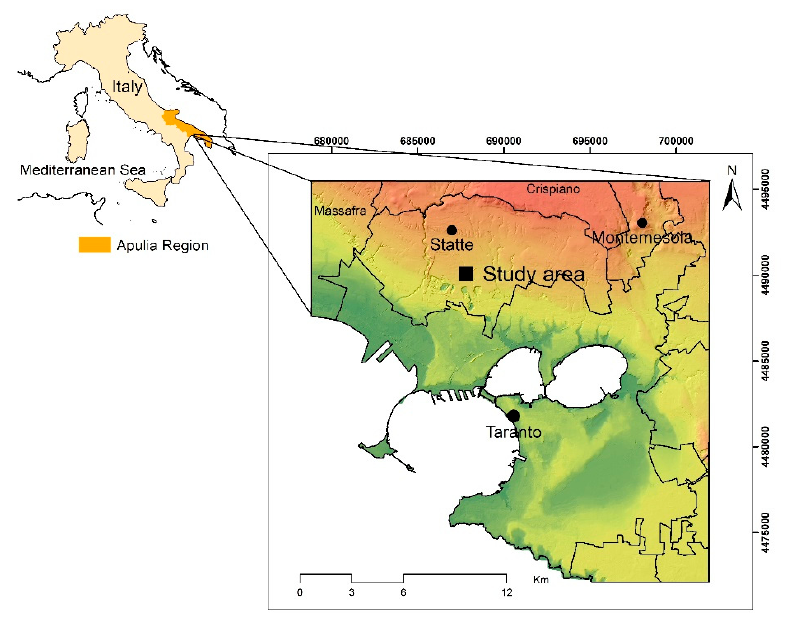
Figure 1. Location of the study site.